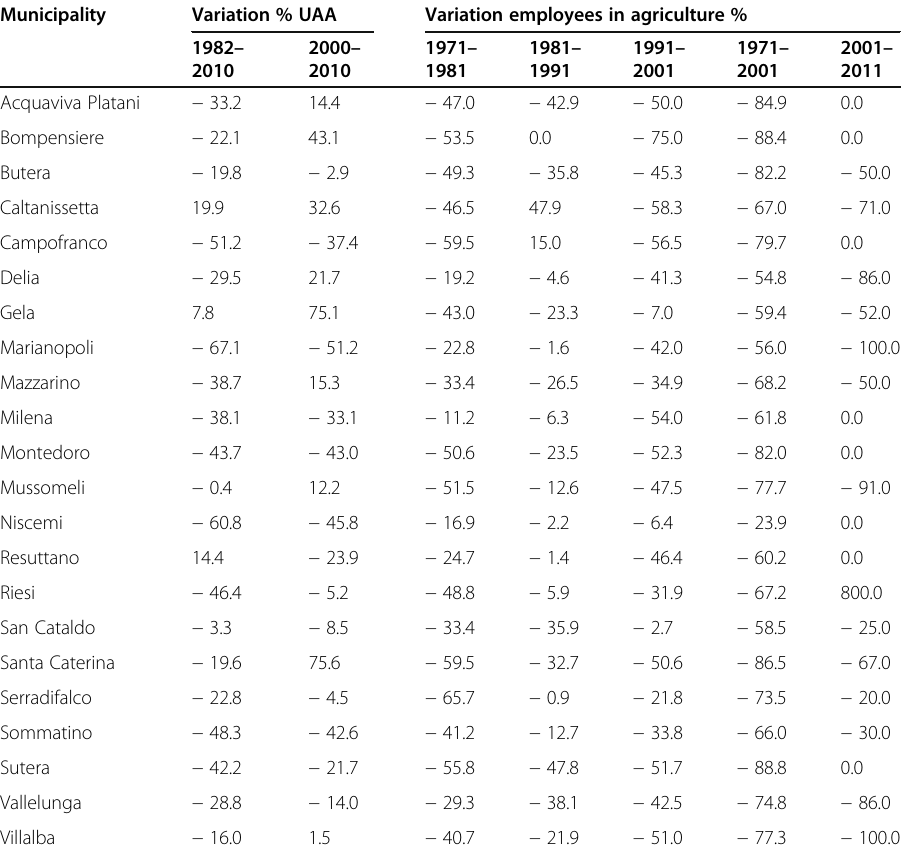
Table 2 Percentage variations of the used agricultural surface (UAA) and of the number of employees in agriculture, forestry, and fishing (1971 – 2011, percentage variations)